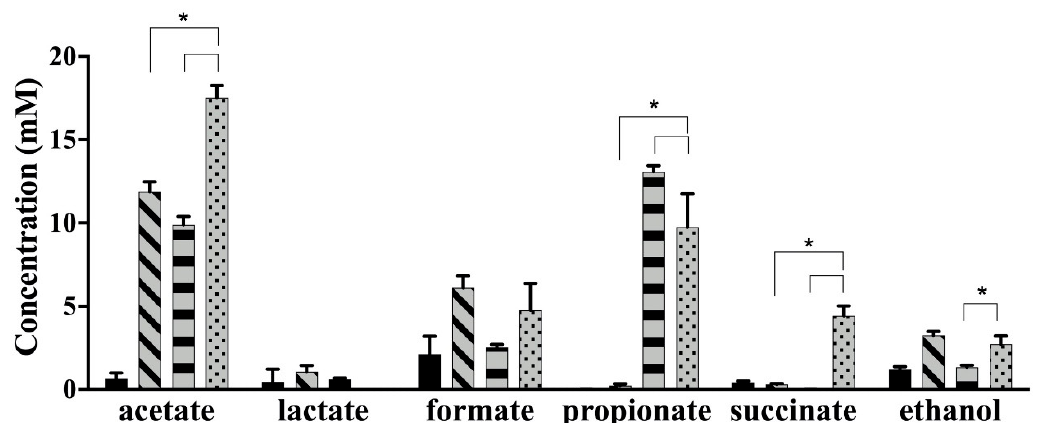
Figure 5. The concentration of short chain fatty acids (SCFAs) and other metabolites in monoculture of B. longum subsp. longum NCC 2705 (grey bar with diagonal lines), Bac. caccae ATCC 43185 (grey bar with horizontal lines), and coculture of both strains (grey bar with dots) in the YC-AG medium for 24 h (YC-AG before inoculation: black bar). Experiments were performed in triplicate. Dunnett’s multiple comparisons test was used to compare each monoculture to coculture (* indicates p < 0.05).